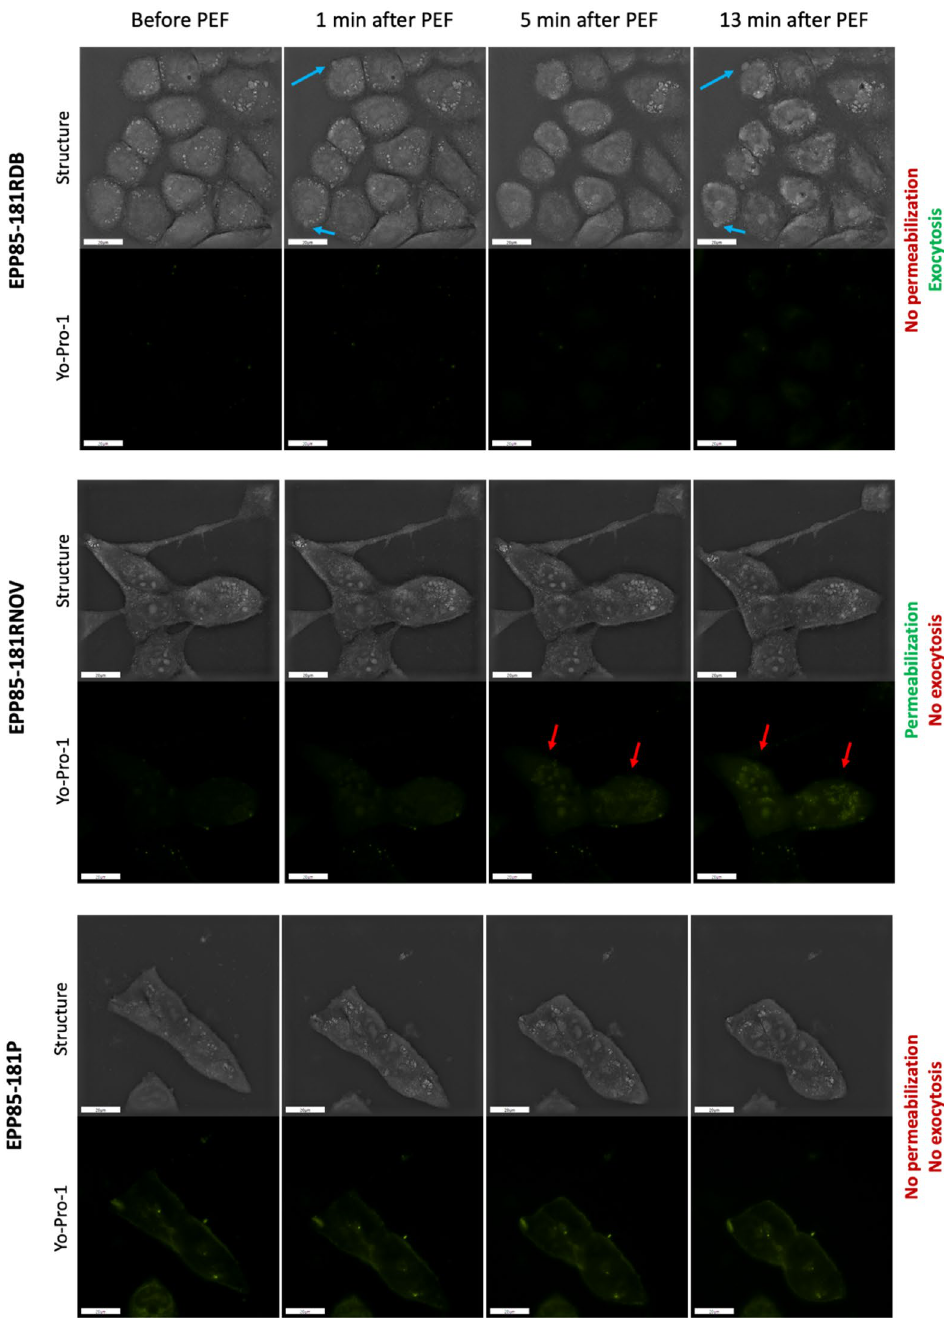
Figure 1. The response of EPP85-181RDB, EPP85-181RNOV and EPP85-181P cell lines to nsPEF (8 kV/ cm, 200 ns, 100 pulses, 10 kHz). The photographs were captured before, 1 min, 5 min and 13 min after pulse application. The top panel shows the ultrastructure of the cells obtained by the holotomography reconstruction and the bottom panel shows the fluorescence of Yo-Pro-1 after the administration of nsPEF, blue arrows—MVs release from the cell membrane, red arrows—YoPro-1 stain signal in the